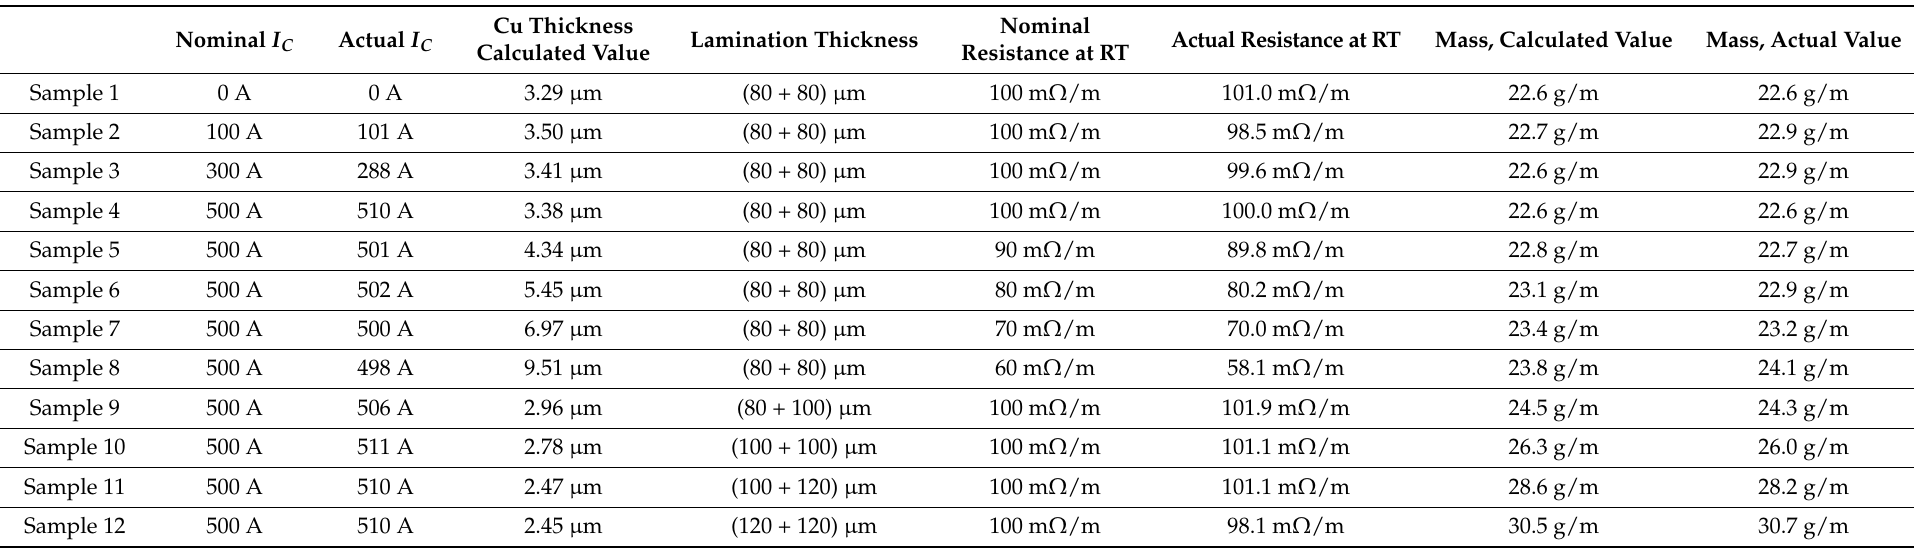
Table 2. Specimen ID and corresponding